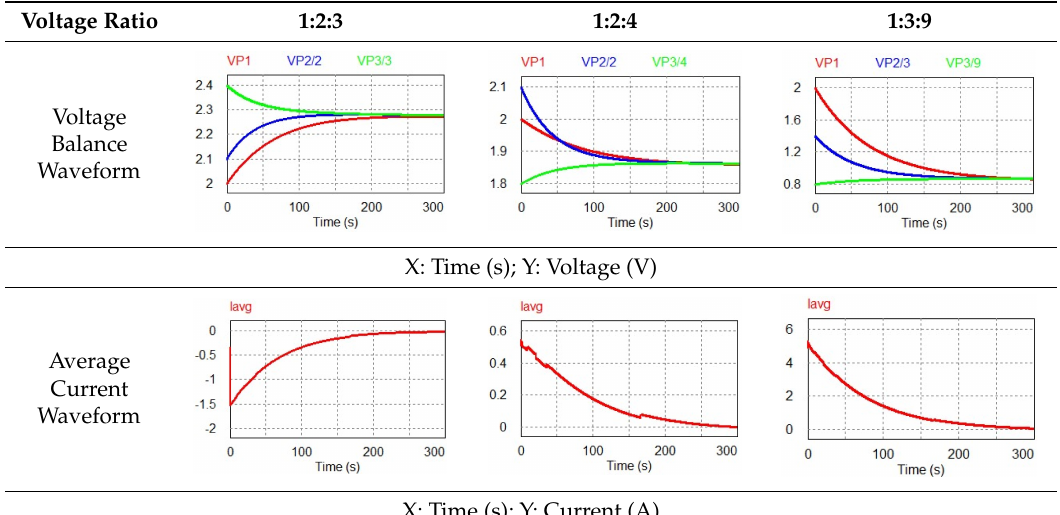
Table 2. Simulation results of the Tapped Inductor voltage equalizer.